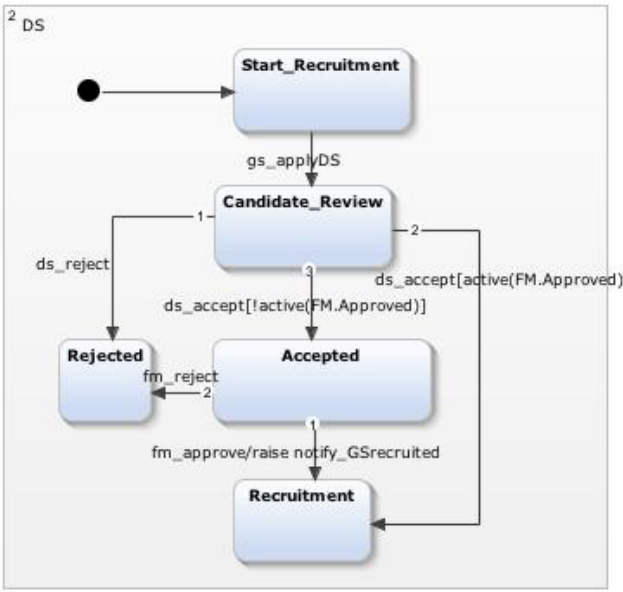
Figure 2 . Statechart model of behavior of the Doctoral School (DS) within the formal PhD recruitment process defined by the